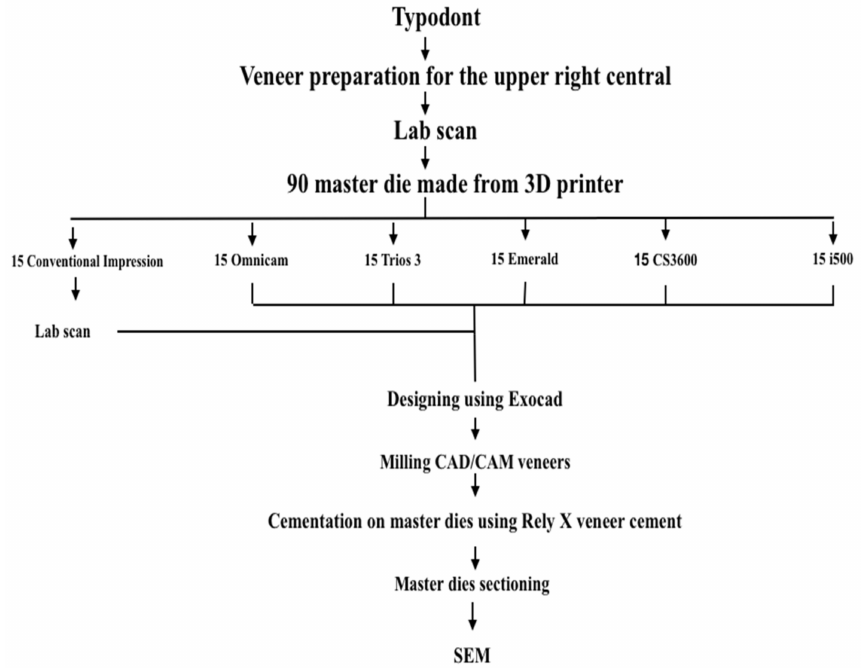
Figure 2. Schematic representation of sampling methodology.